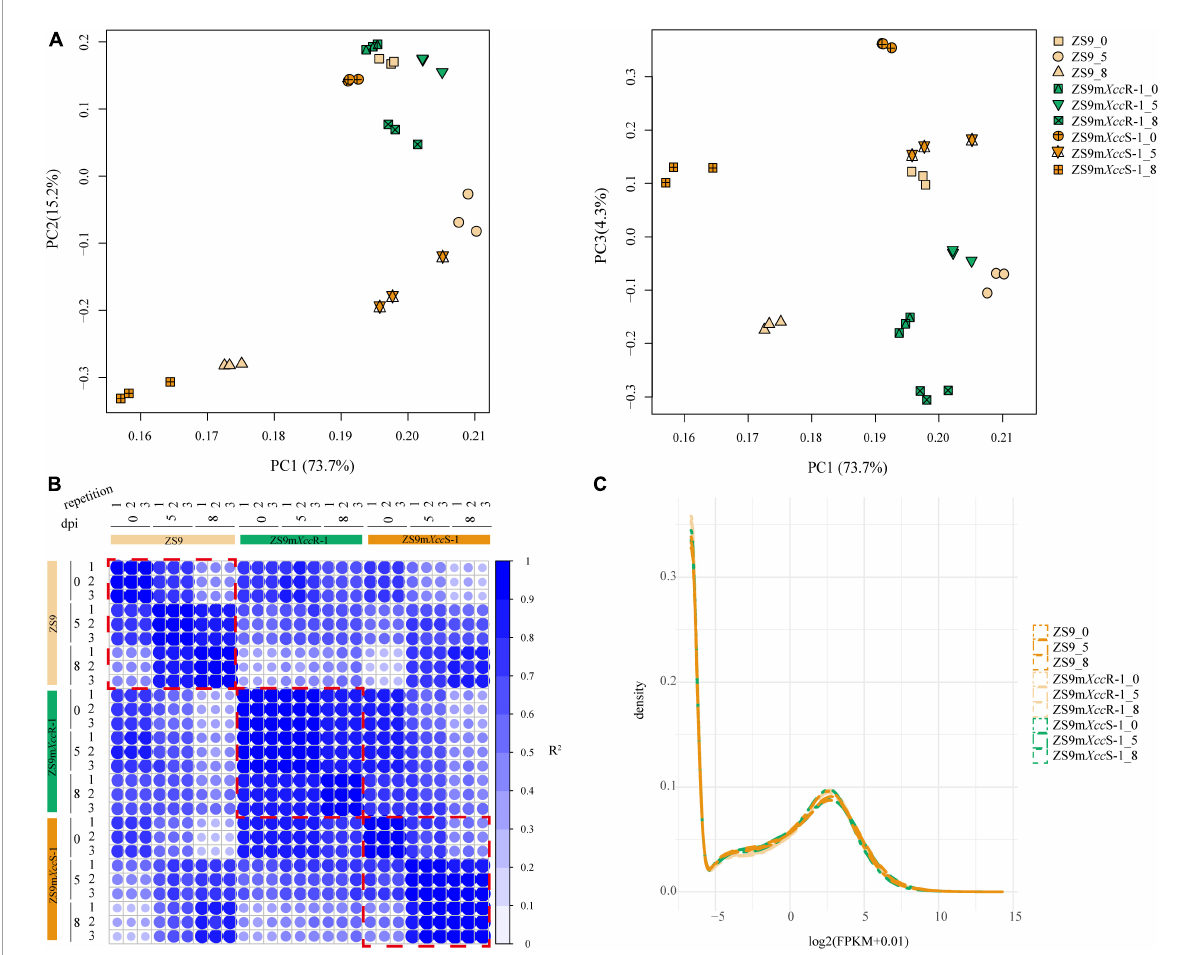
FIGURE2 Quality evaluation of RNA-seq data. (A) PCA displaying the major composition of variance. Left panel: 73.7 and 15.2% of the variance referred to PC1 and PC2, respectively. Right panel: 73.7 and 4.3% of the variance referred to PC1 and PC3, respectively. (B) Representation of correlation matrix between RNA-seq samples based on Pearson correlation coefficients. Numbers represent biological repetitions. (C) Frequency histogram representing the distribution of gene expression levels across samples. Numbers 0, 5, and 8 indicate days post